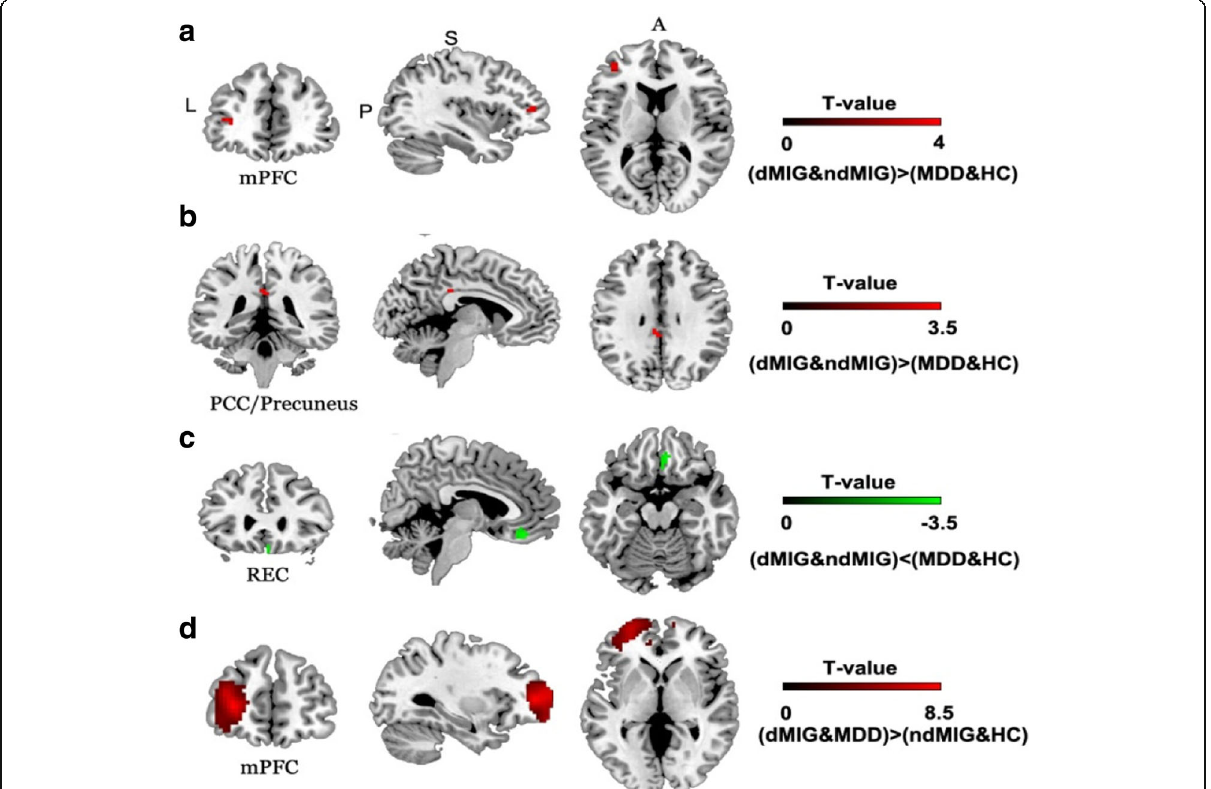
Fig. 1 Significant main effect of migraine. Significant main effect of migraine in left medial prefrontal cortex ( a ), the bilateral posterior cingulate cortex/ precuneus ( b ) and the right rectus gyrus ( c ) and main effect of depression in left medial prefrontal cortex ( d ); mPFC: medial prefrontal cortex; REC: rectus gyrus; PCC: posterior cingulate cortex. dMIG: migraineurs with depression; ndMIG: migraineurs without depression; MDD: patients with major depressive disorderand; HC: healthy controls; mPFC: medial prefrontal cortex; PCC: posterior cingulate cortex; REC: rectus